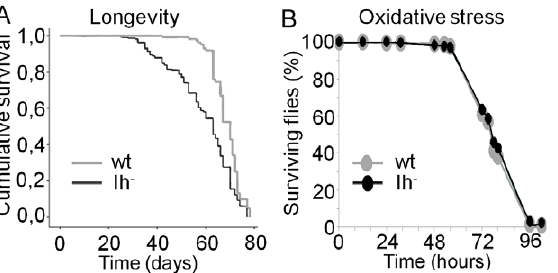
Figure 8. The absence of Ih current shortens lifespan but does not affect resistance to oxidative stress. (A) Lifespan determina- tion of DmIh mutant males (black line, n=234) compared to controls (gray line, n= 145). Survival curves of the two genotypes are significantly different (Mantel-Cox Statistic=32.281, df=1, p , 0.0001). (B) Resistance to oxidative stress of DmIh mutant males (black line, n=511) is not different from the controls (gray line, n=384).